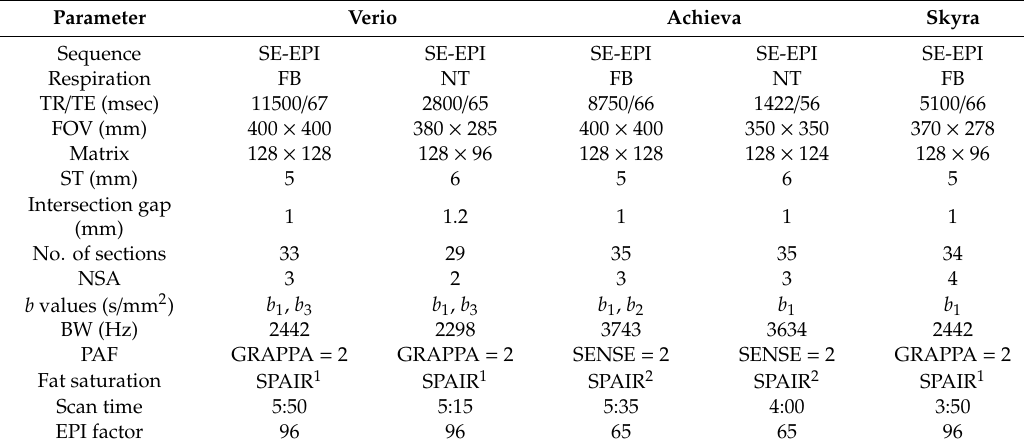
Table 1. Parameters for di ff usion-weighted imaging (DWI)